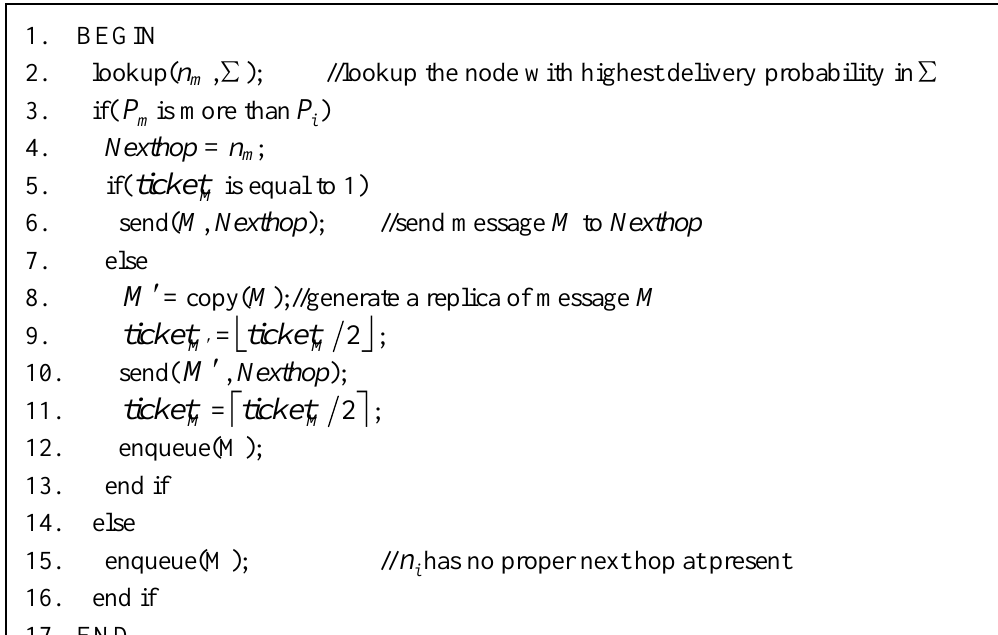
Figure 2. Pseudo-code of the data delivery